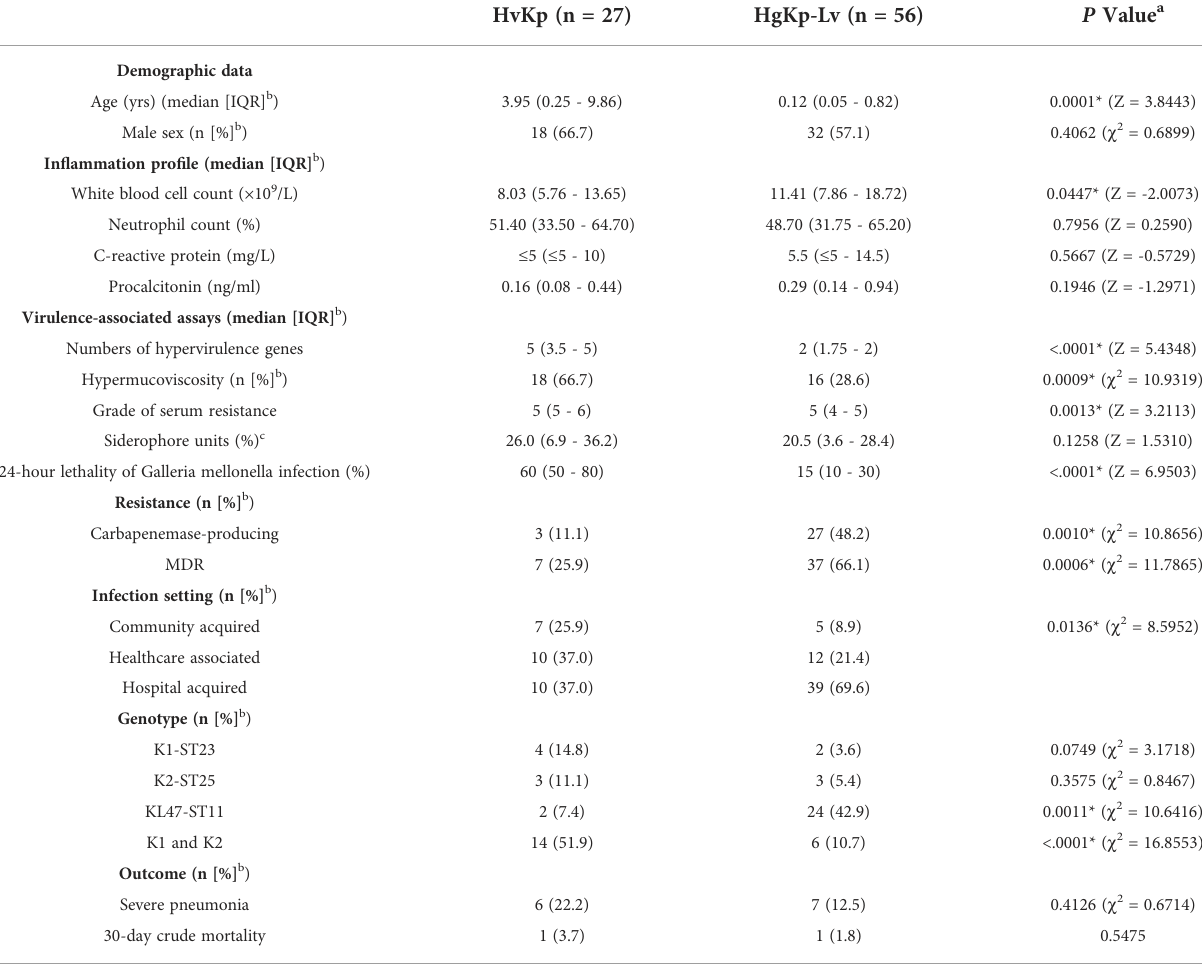
TABLE 1 Comparison of characteristics between hypervirulent K. pneumoniae (hvKp) isolates (n = 27) and hypervirulence genes-positive K. pneumoniae - low virulence (hgKp-Lv) isolates (n =